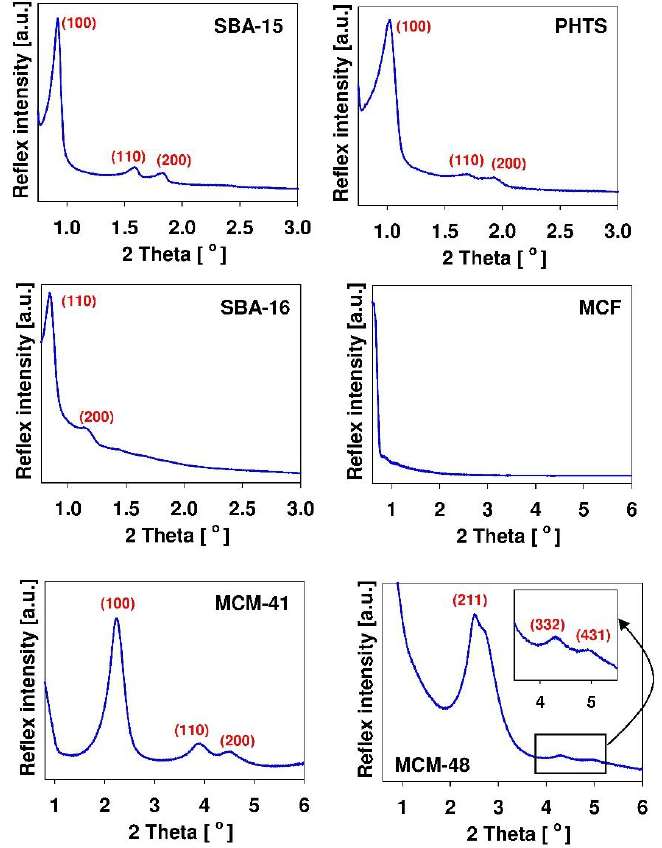
Figure 3. Typical XRD patterns of chosen mesoporous silicas with indices of the diffraction planes. The diffractograms were collected using Bruker D2 PHASER apparatus and come from the authors’ own collection.